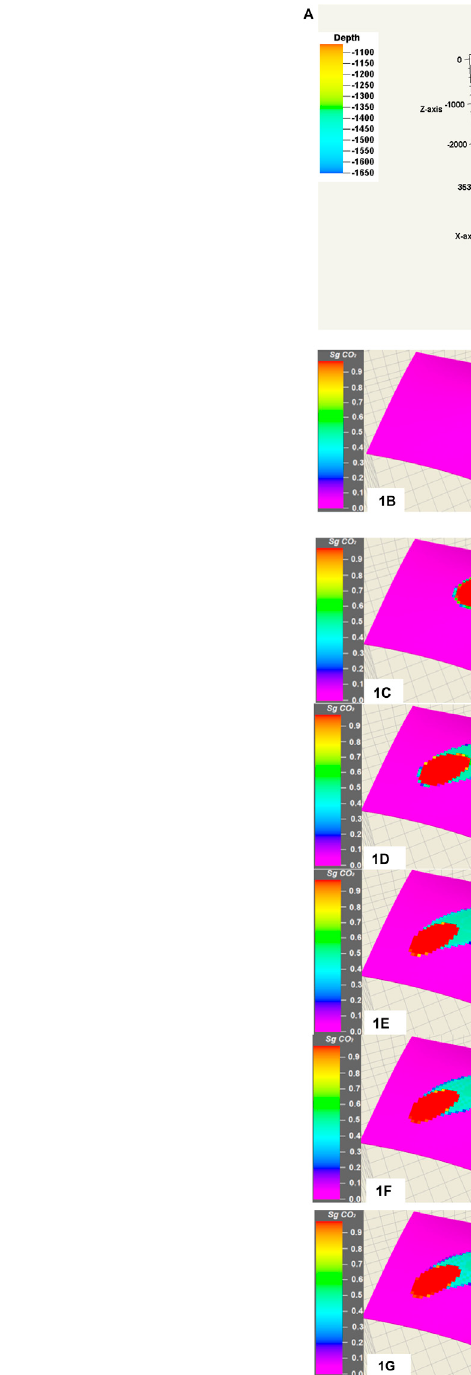
Frontiers in Energy Research |